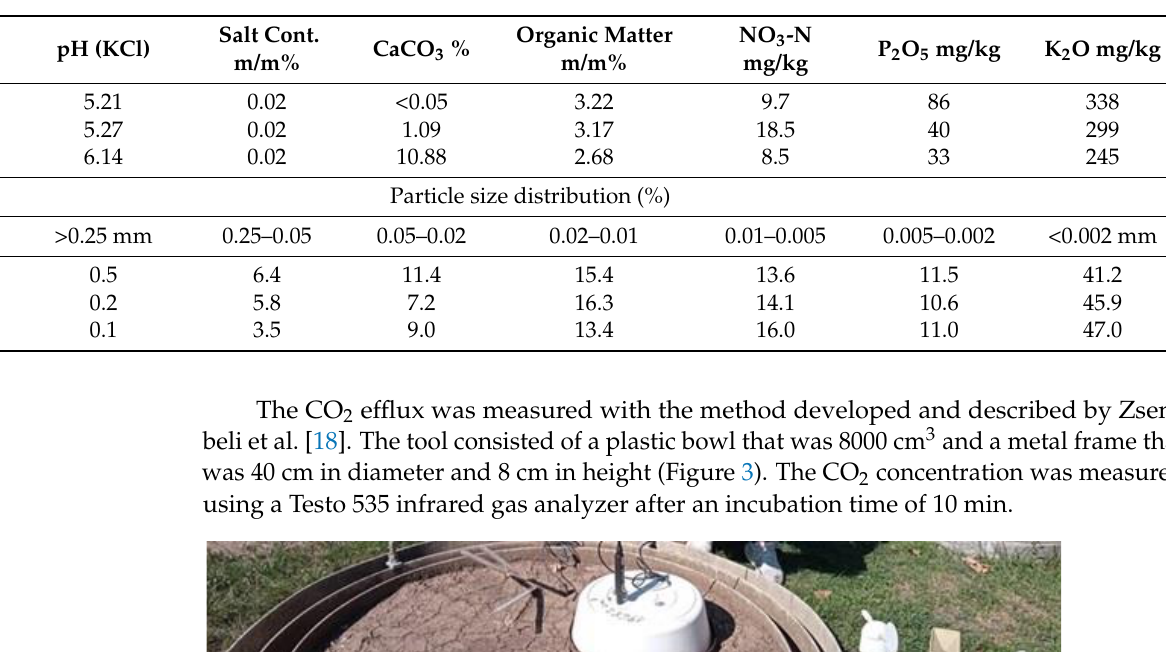
Figure 2. Monthly precipitation values during the investigated period (Karcag, 2018–2022). Table 1. Main soil properties of the studied soil in Karcag, Hungary.